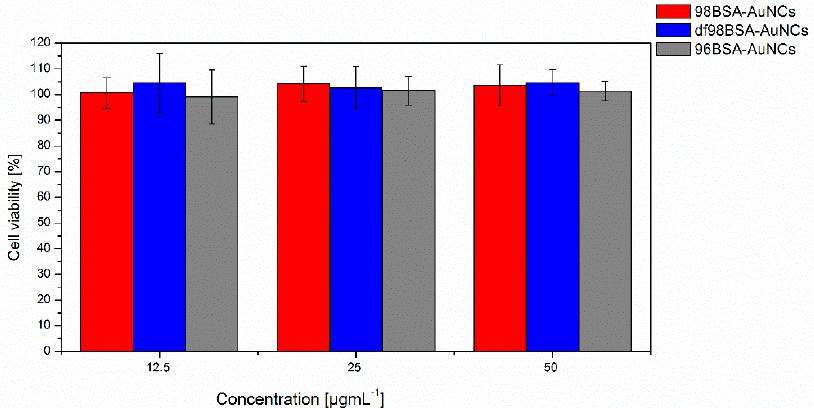
Figure 6. Viability of cells exposed to AuNCs. Value of absorbance was normalized to control cells that were not labeled with AuNCs. Control was set to 100%. Treated cells were labeled for 24 h with 96BSA-AuNCs (grey columns), or 98BSA-AuNCs (red columns), or df98BSA-AuNCs (blue columns) in concentrations of 12.5, 25, or 50 µ g Au / mL. Data are expressed as a mean of three independent experiments ± standard deviation (SD).